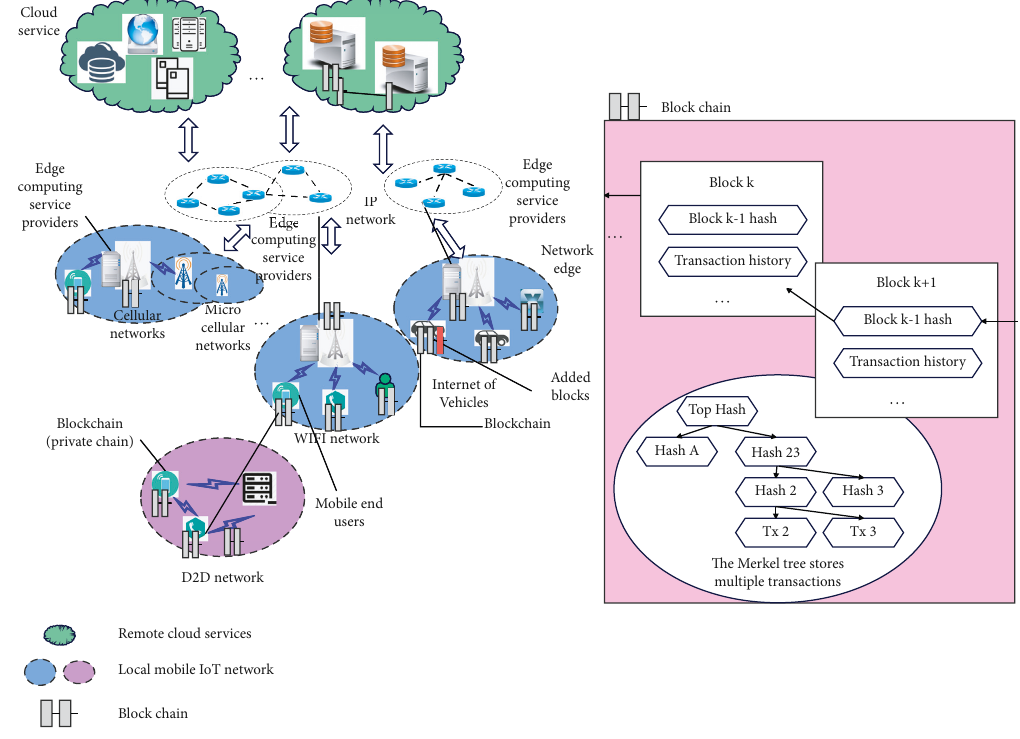
Figure 7: Combination of blockchain and new technologies. Table 1: Risk identification effect of the financial risk aversion model based on sensor and edge